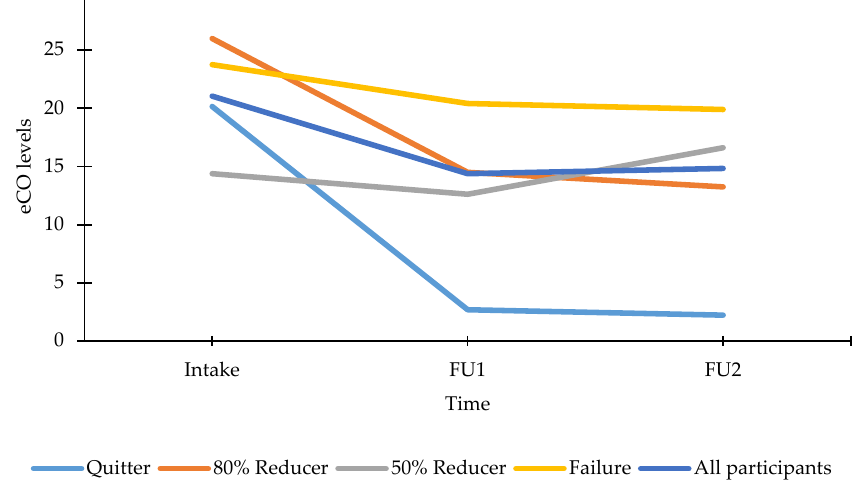
Figure 4. eCO measurements at intake, FU1, FU2 for all participants and reduction rate groups as calculated at FU2. Note: All participants: n intake–FU1–FU2 = 59, M intake (SE between brackets) = 21.05 (1.47), M FU1 = 14.39 (1.59), M FU2 = 14.83 (1.50); Quitters: n intake–FU1–FU2 = 13, M intake =